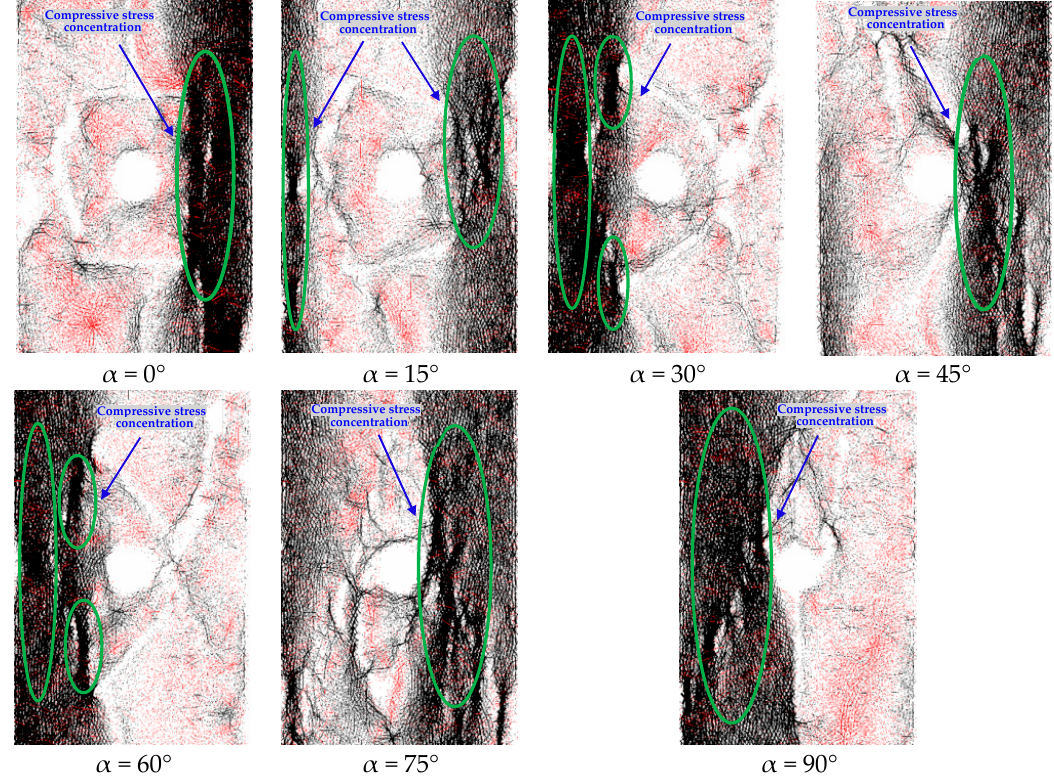
Figure 10. The distributions of contact force chains after model failure in the crack-circle composite model.